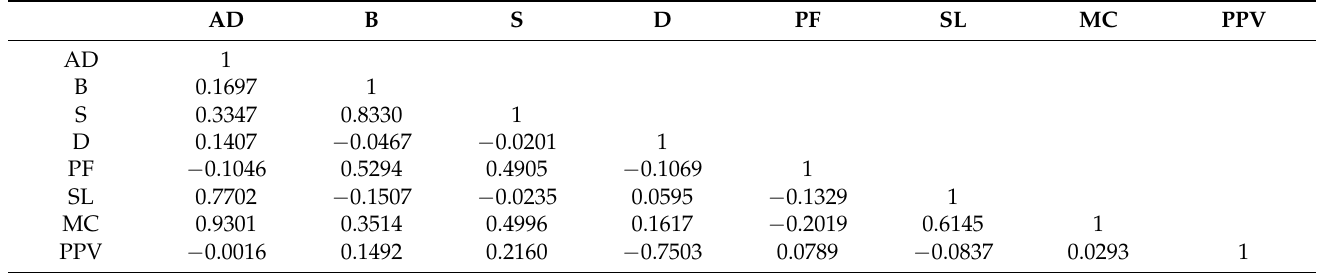
Figure 4. Portable ground vibration monitoring station in realistic conditions (at Shree Cement Ras Limestone Mine in India). Table 5. Matrix of Correlation Coefficients Between Input Parameters and PPV Measured.